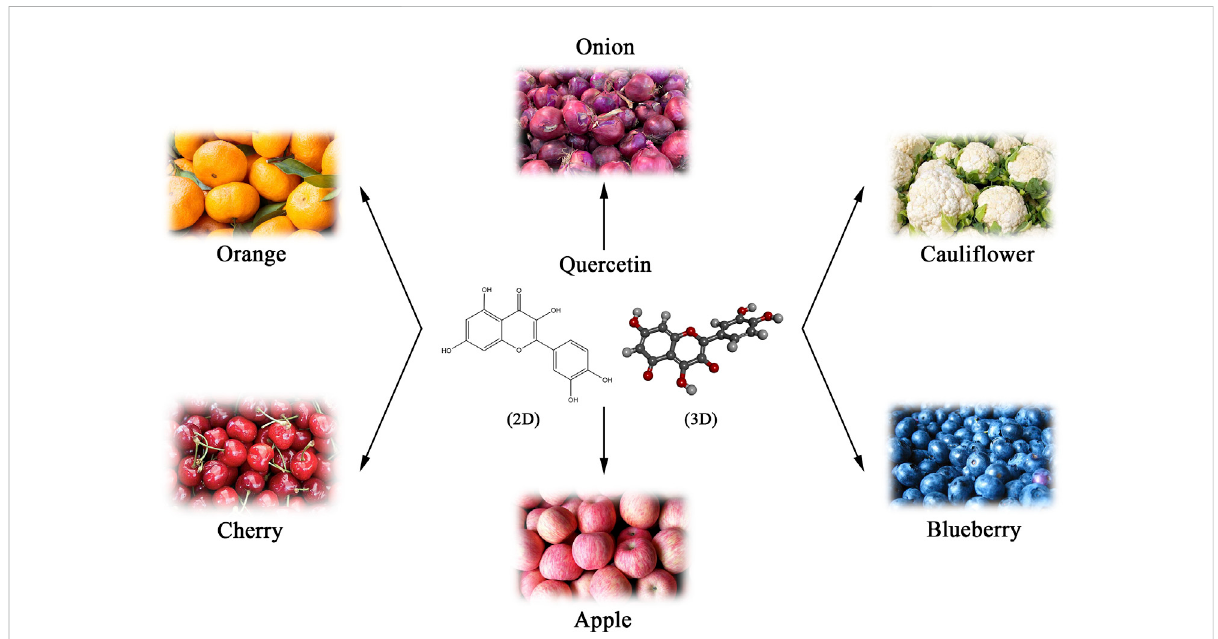
FIGURE 1 Natural sources and chemical structure (Skeletal formulas and 3D stick representations) of